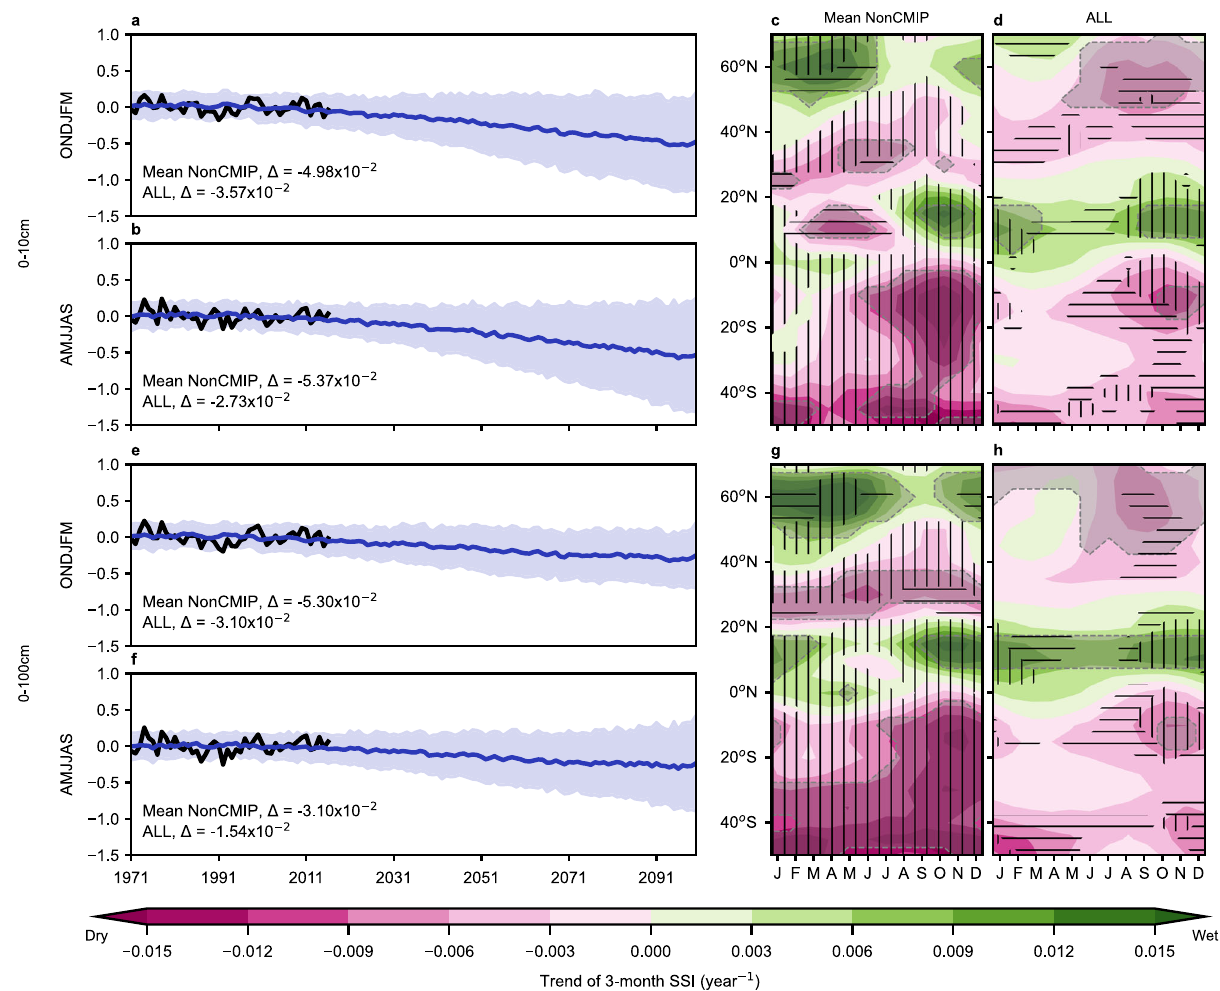
Fig. 1 | Historical and future evolution of the 3-month Standardized Soil MoistureIndex(SSI)inthe0 – 10cmand0 – 100cmsoillayers.a , b , e , f Theglobal mean time series of the October – March (ONDJFM) and April – September (AMJJAS) average SSI. Black lines represent the pseudo-observation (Mean NonCMIP). Blue lines and blue shading represent the average and 95% con fi dence intervals of the ALL simulations (forced by all anthropogenic and natural forcing agents). Δ represents the difference between the mean SSI of 1987 – 2016 and 1971 – 1986. c , g The month-by-latitude SSI trends over 1971 – 2016 of the pseudo-observation. Vertical hatching indicates where the trends had the same signs as the average trends of the ALL simulations. Horizontal hatching indicates where the trends had